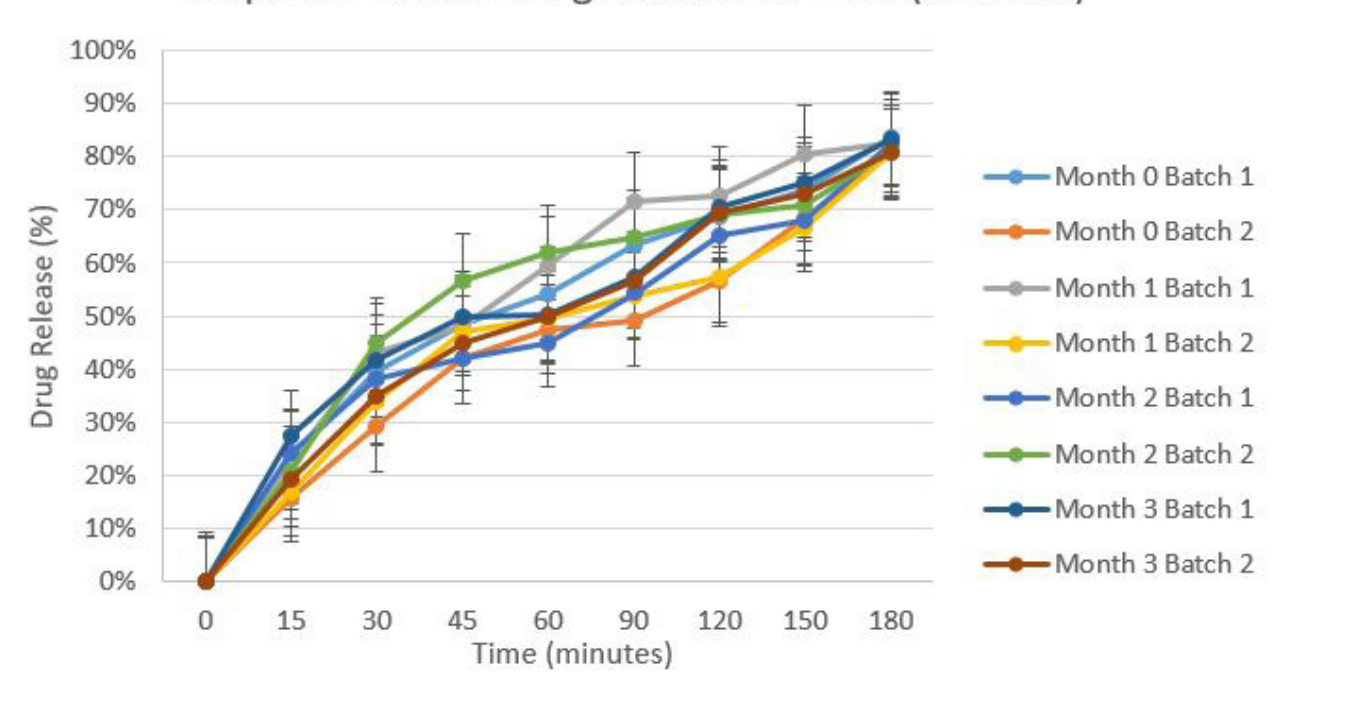
FIGURE 11 - Graph of percent release vs. time in minutes.